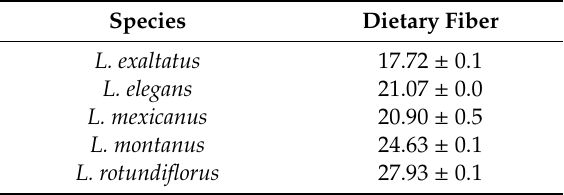
Table 11. Dietary fiber (DF) content in five Mexican species of lupines.